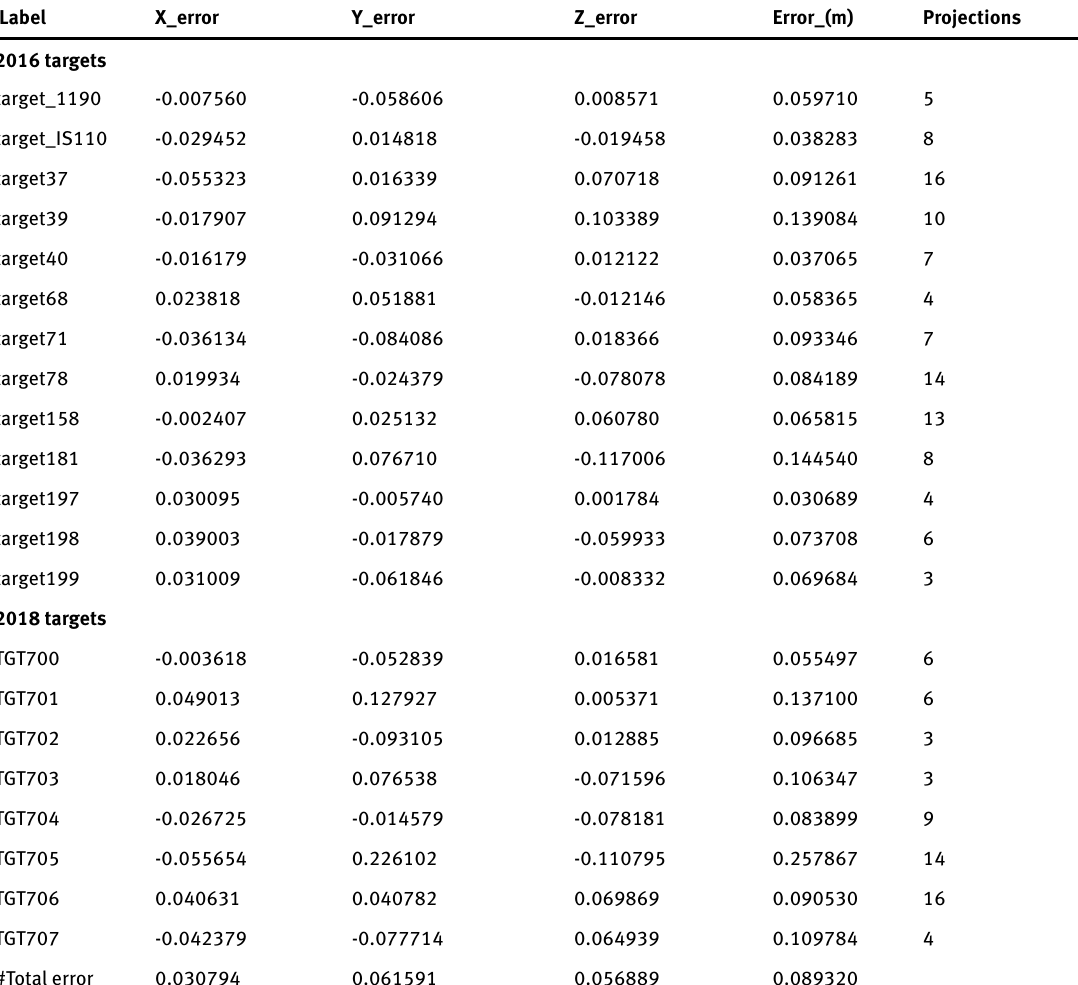
Table 3. Agisoft PhotoScan calculated errors between the GPS control point positions and the positions calculated for the same points in the 3D model generated (© M. Hernández